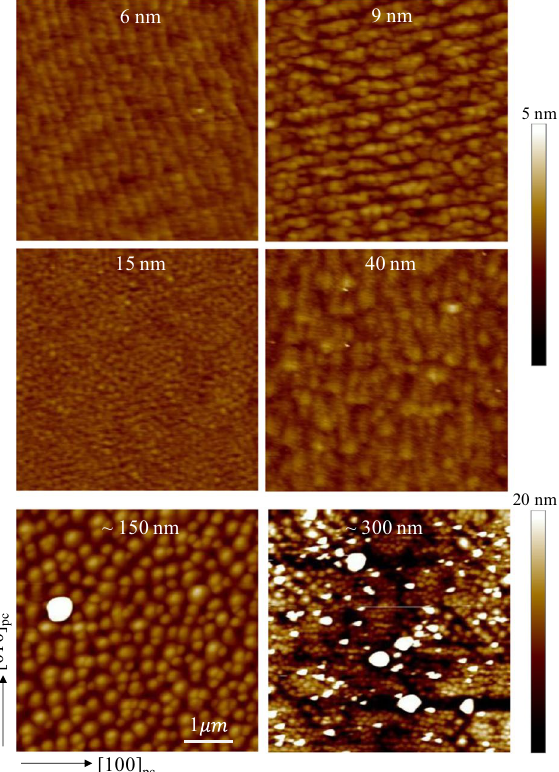
Figure 5. Surface topographic images for the thickness-series of samples. Granularity is observed in all the samples. The typical grain size doesn’t show a correlation with film thickness. The two thickest samples (~150 nm and ~300 nm) exhibit significantly higher surface roughness than the